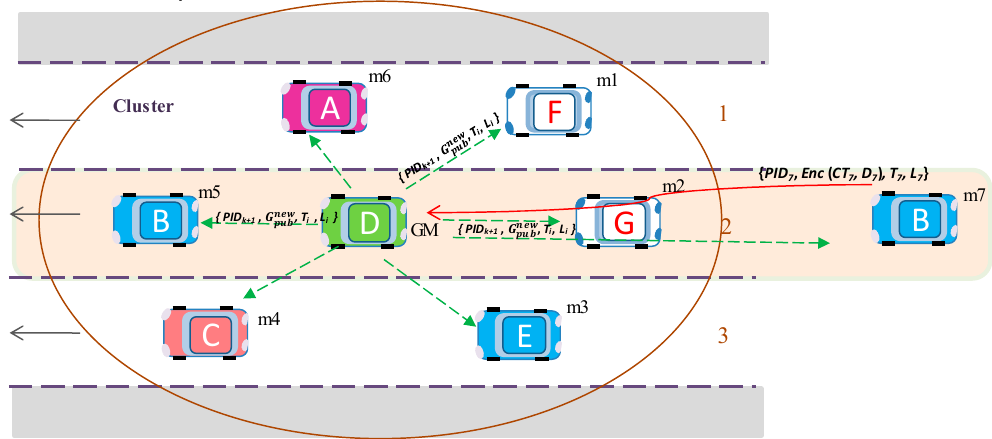
Figure 9. The rekeying mechanism for a new member joining the group.